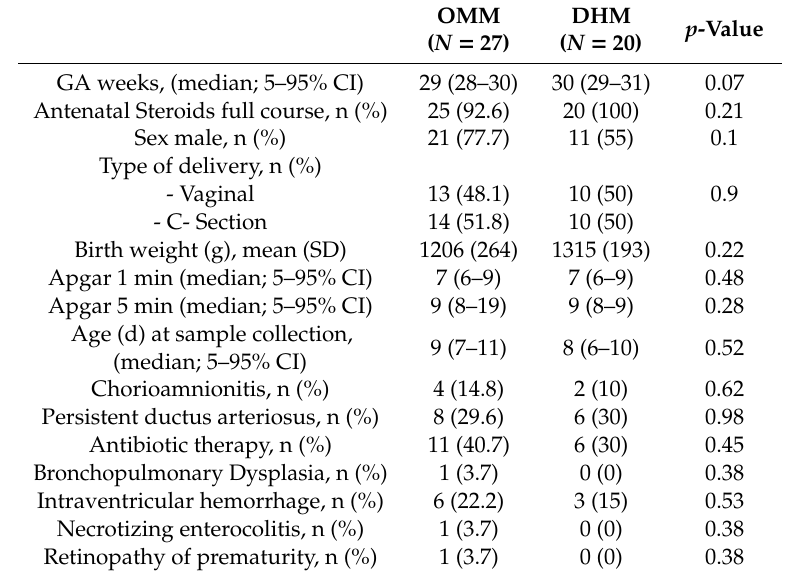
Figure 1. Flowchart of patients’ recruitment. A total of 47 preterm infants < 32 weeks’ gestation or < 1500 g were recruited. Out of these, 27 were fed with their own mother’s milk (OMM) and 20 with pasteurized donated human milk (DHM). Table 1. Demographic, perinatal, clinical, and analytical data of preterm infants < 32 weeks’